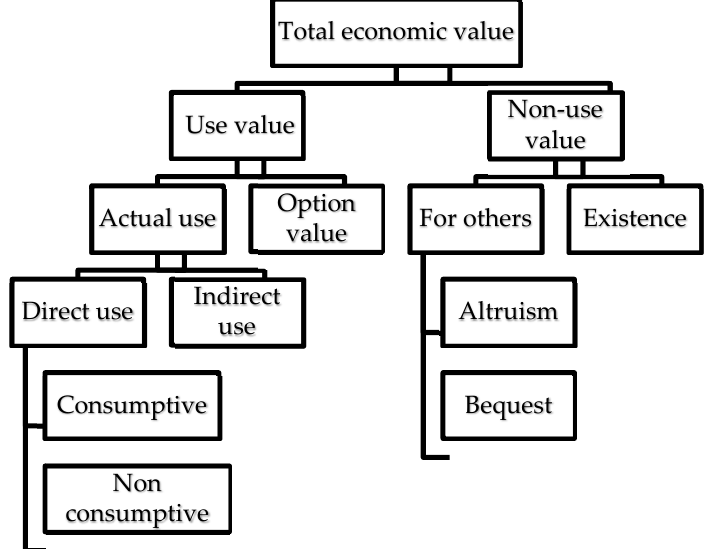
Figure 1. Total Economic Value. Adapted from Bateman ([61] p. 29), Pearce ([75] p. 87) and TEEB ([64] p. 14).